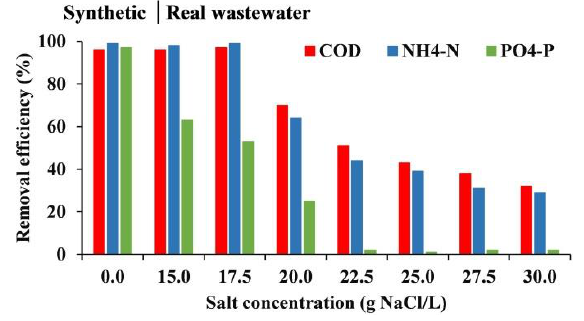
Figure 1. COD, NH -N and PO -P removal 4 4 efficiency from fish canning wastewater at different salt concentration, and from synthetic wastewater without salt